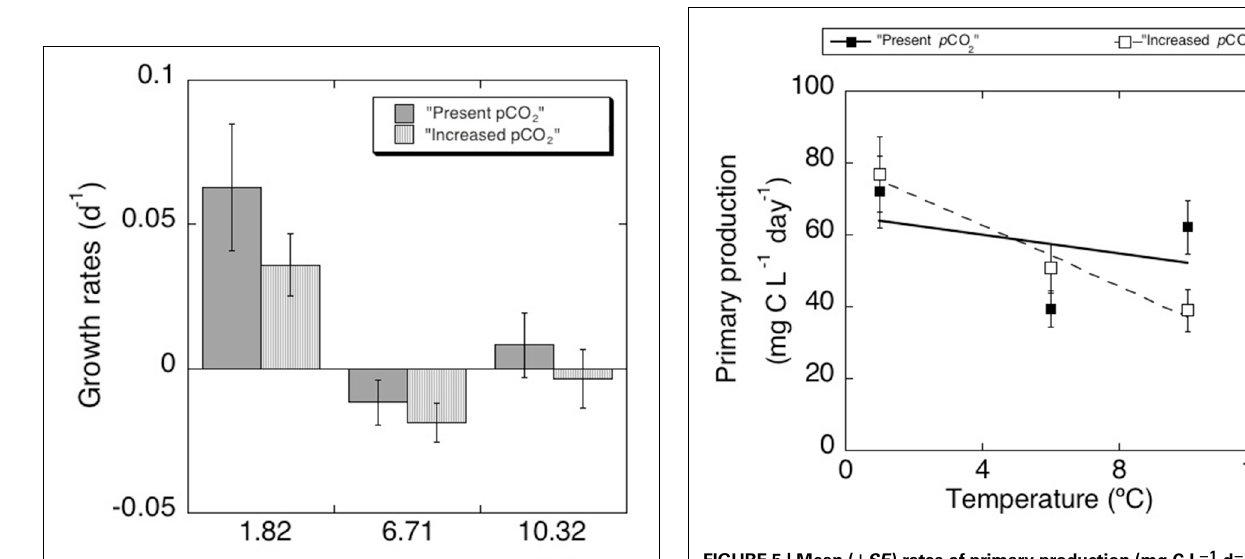
FIGURE 5 | Mean ( ± SE ) rates of primary production (mg C L − 1 d − 1 ) averaged across 4 sampling days for treatments of “present p CO 2 ” (black squares) and “increased p CO 2 ” (white squares). significant interaction between increased p CO 2 and temperature was found for the changes experienced in total biovolume ( p < 0 . 05), and more specifically in the biovolume of centric diatoms 11.1 µ m ( p < 0 . 05) ( Table 2 ). The average initial percentage of living cells in the commu- nity was estimated at 75.3% for centric diatoms 7 µ m and 43.1% for flagellates 5.9 µ m, the dominant groups at the beginning of the experiment. The living cell abundance increased with tem- perature and under higher p CO 2 levels for centric diatoms 7 µ m ( p < 0 . 05), but the presence of both factors resulted in a